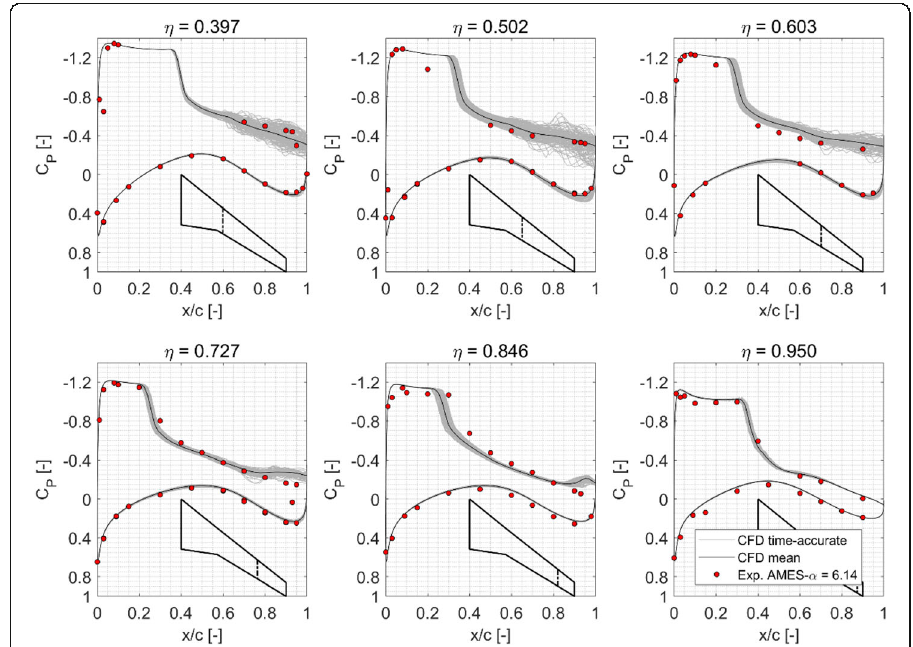
Fig. 10 Computed time-accurate, and mean C P slices at M = 0.85, Re = 5 m, and α = 6° in comparison with experimental values